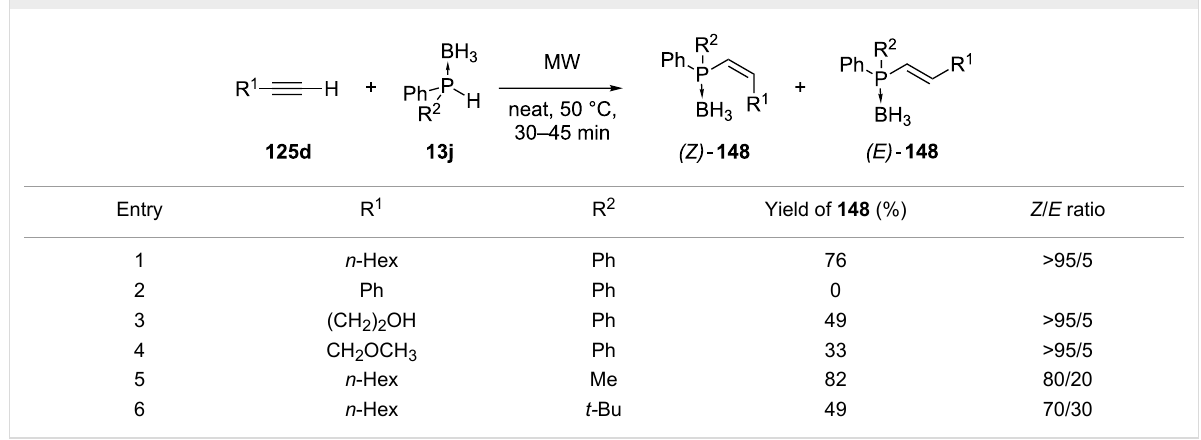
Table 17: Hydrophosphination reactions of terminal alkynes 125d with phosphine boranes 13j under microwave